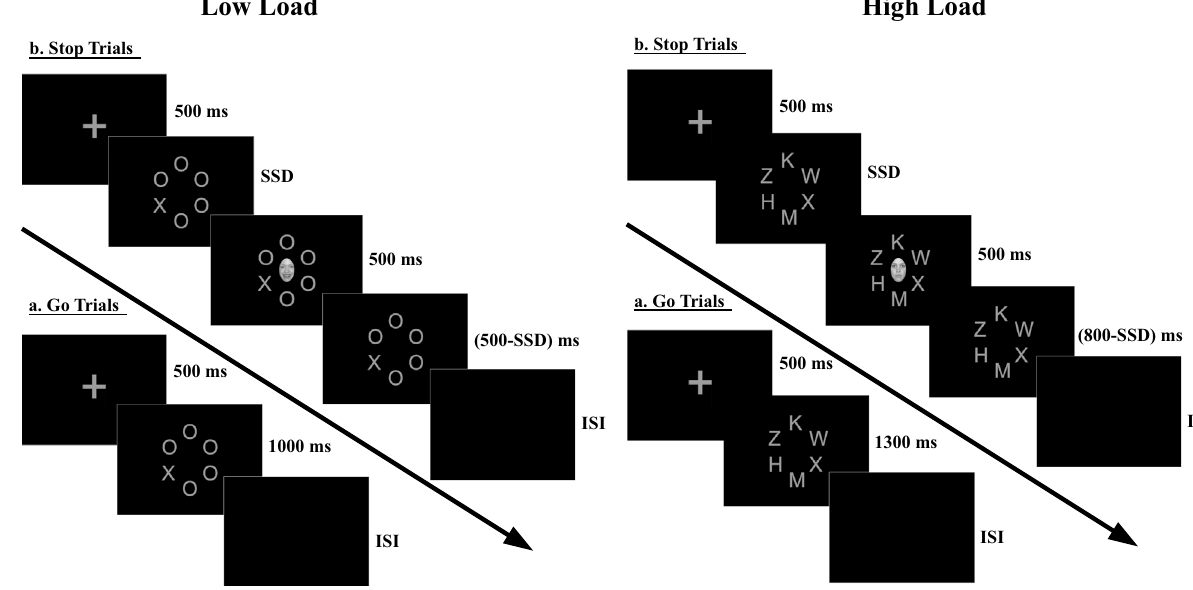
Figure 3. An example of go and stop trials. All protocols were the same as Experiment 1 except now cropped greyscale faces with irrelevant angry, happy, or neutral expressions appeared as stop-signal. Also, letter string was presented circularly. SSD: Stop-Signal